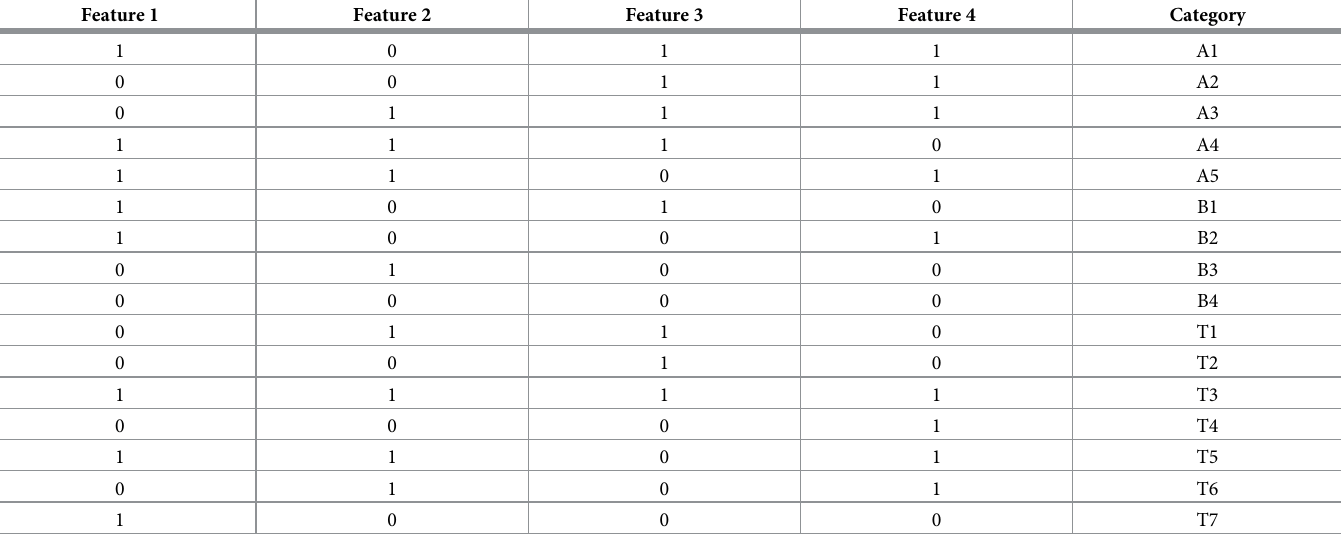
Table 3. Category structure used in [10].